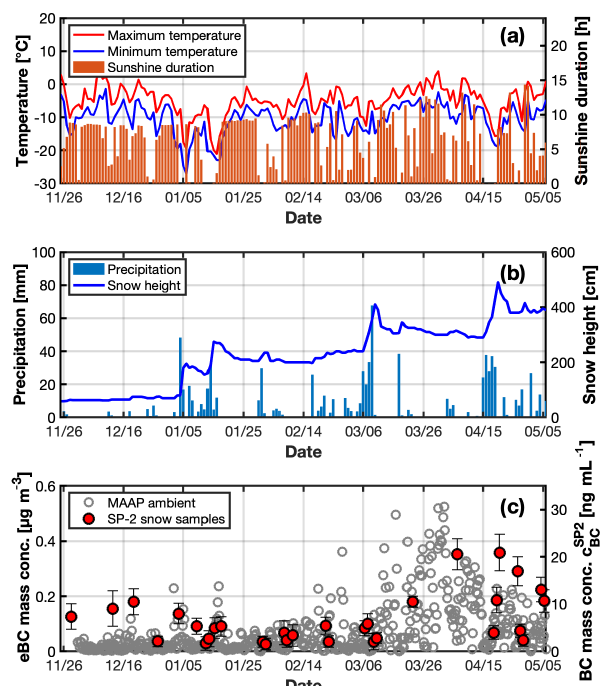
Figure 5. Overview of the meteorological and ambient BC condi- tions during the period the snow samples were collected at UFS. The data in (a) to (b) are on a daily basis. The atmospheric equivalent black carbon (eBC) mass concentrations shown in panel (c) rep- resent 30min averages of the MAAP measurements. Note that the refractory black carbon mass concentrations, c SP2 , deduced from BC the SP2 measurements of the re-aerosolized snow samples are com- pared in panel (c) with the atmospheric eBC mass concentration. See text for details concerning data providers, sampling, and mea- surement